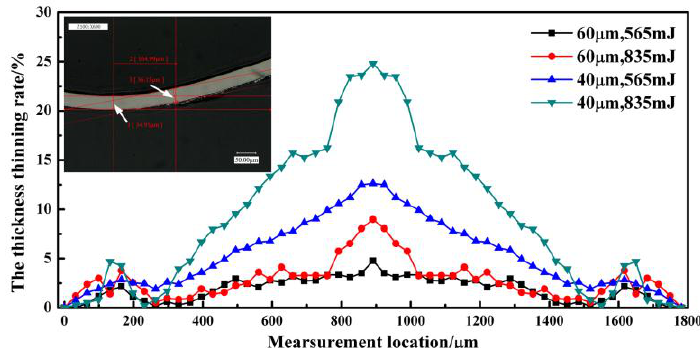
Figure 9. The experimental results of the thickness thinning rate of the micro bulging parts.